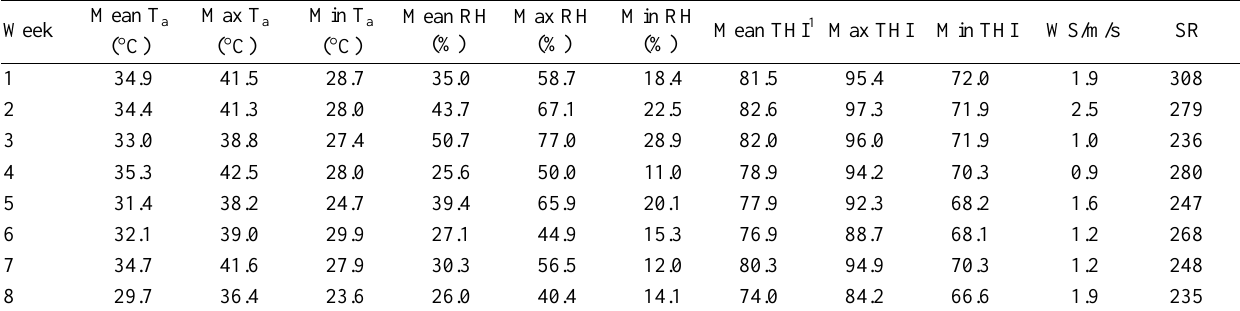
Table 2. Ambient temperature (Ta), mean relative humidity (RH), mean temperature-humidity index (THI), mean wind speed (WS), and solar radiation (SR) registered during experiment Mean T Week